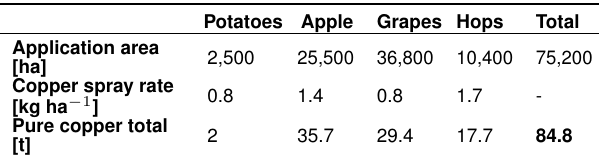
Table 1. Estimated amounts of copper used [pure copper in kg ha − 1 ] in conventional farming in Germany in 2013 relative to the application area.